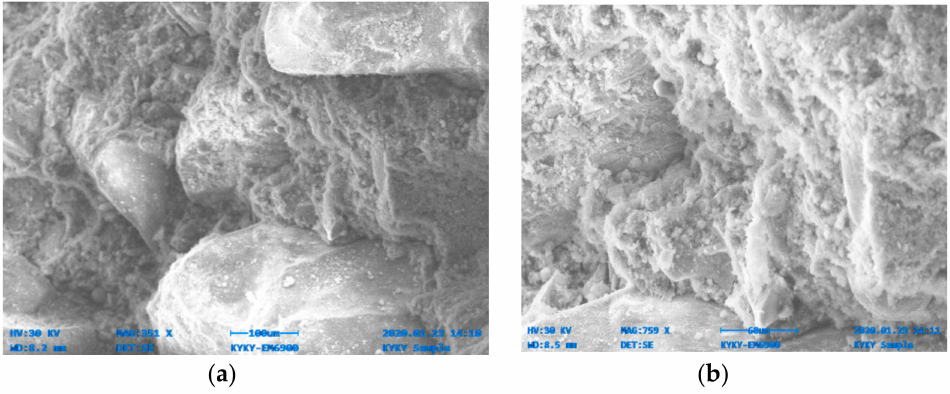
Figure 15. The SEM image of GPC-B0F mix specimen; ( a ) magnification 351 × ; and ( b ) magnification 759 × .